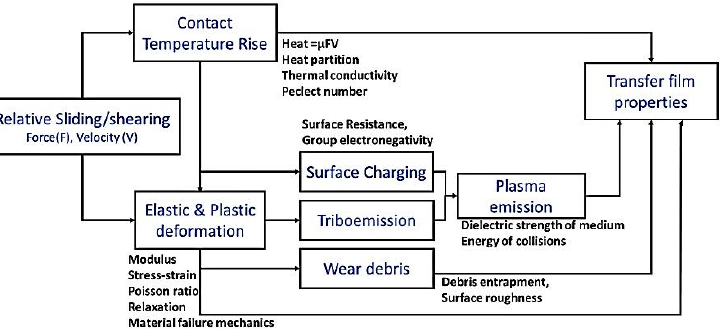
Figure 5. Factors effecting functional properties of polymeric TFs upon sliding PEEK on the steel surfaces. Figure is reproduced with permission from reference [24].